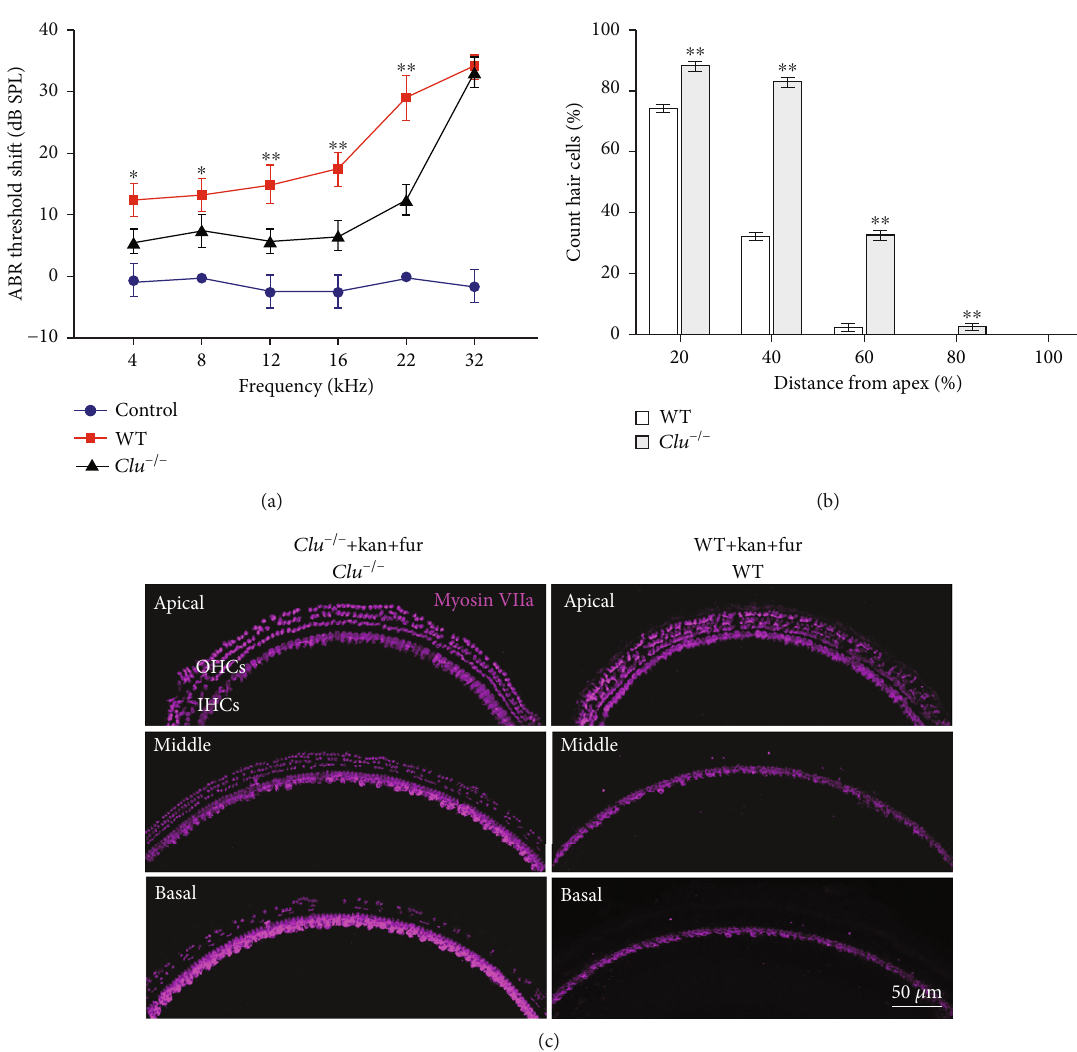
Figure 6: Clu de fi ciency protects hearing ability and inhibits sensory cell death induced by the coadministration of kanamycin and furosemide. (a) Assessment of auditory dysfunction in WT and Clu − / − mice treated with furosemide plus kanamycin. N = 6 . (b) Quanti fi cation of OHCs and IHCs in WT and Clu − / − mice after treatment with furosemide plus kanamycin. Data are presented as the mean ± SD . ∗ p < 0 : 05 , ∗∗ p < 0 : 01 . N = 6 . (c) Representative confocal microscopy images from WT and Clu − / − mice after treatment with furosemide plus